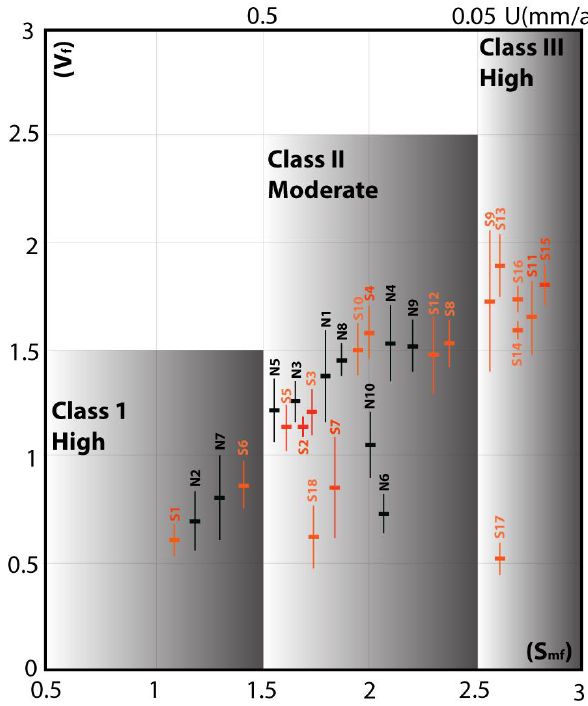
Figure 9. Plot of S mf and V f for the mountain fronts of all segments and different tectonic activity classes. Vertical bars indicate the V f index standard deviation for values. The authors of Ref. [2] applied a method that used S mf and V f results to define the tectonic activity classes. Mountain fronts indicated by active signatures have low S mf val- ues (1.00:1.50), whereas higher values of S mf (>3.00) indicate fronts that are strongly af-